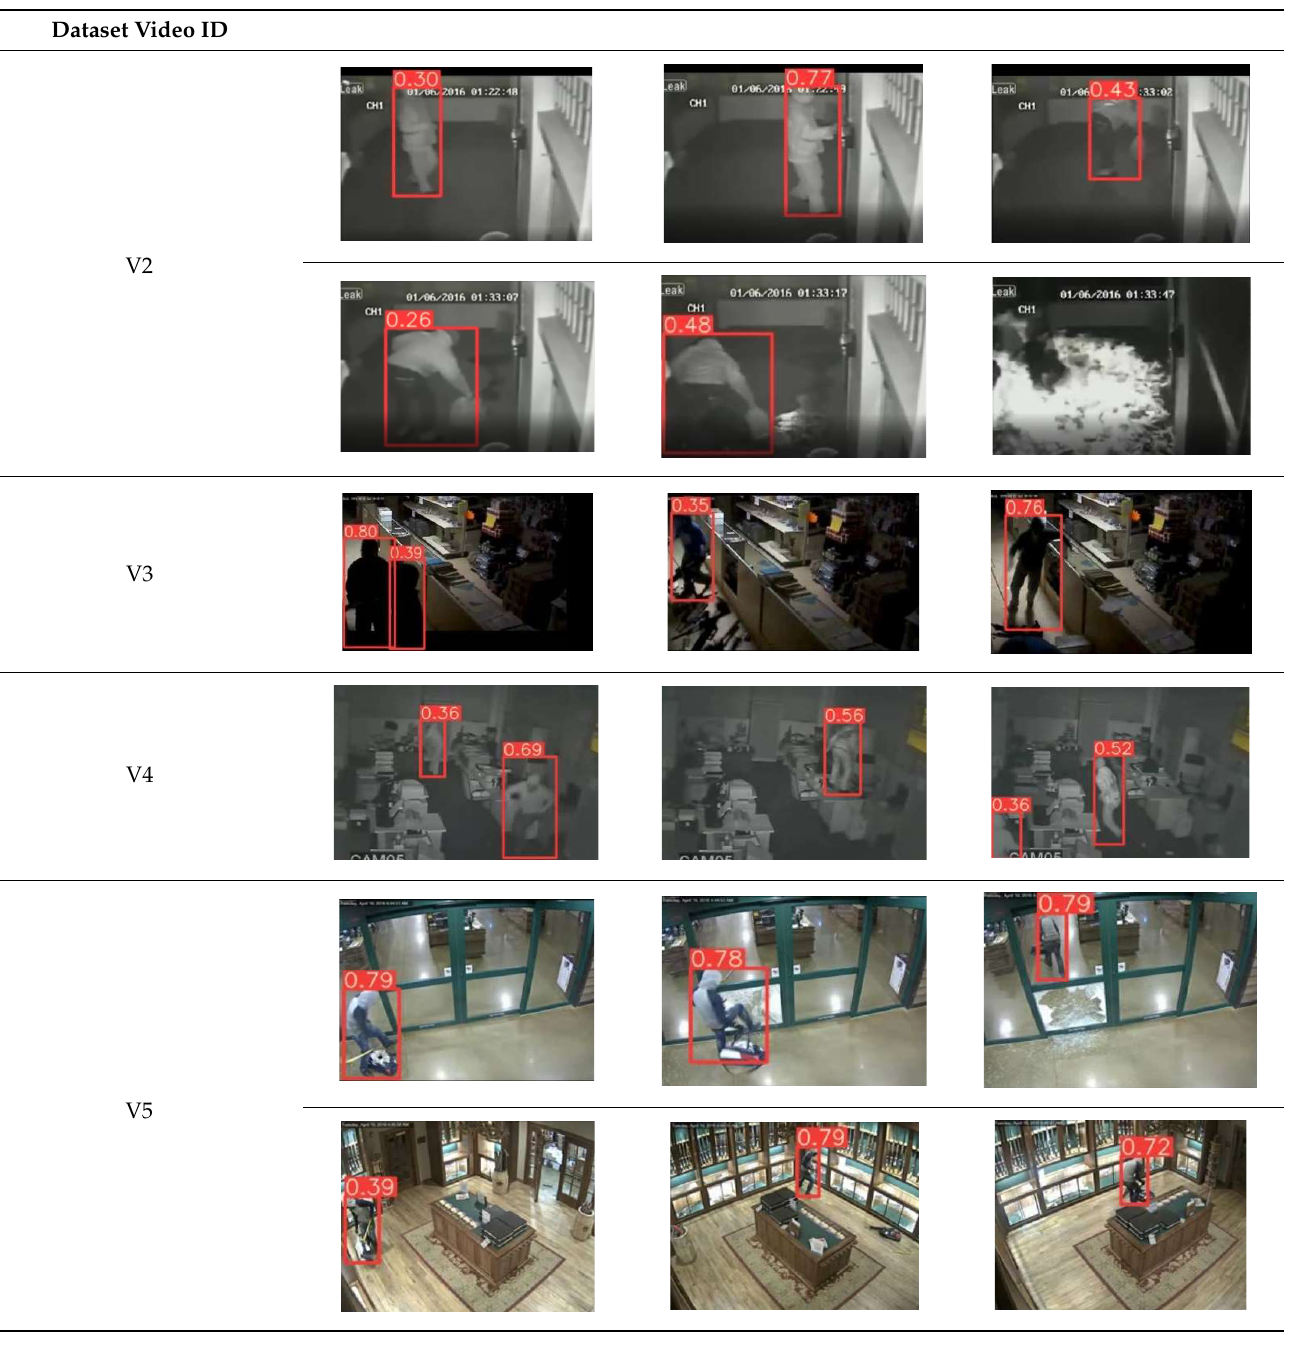
Table 5. Quantitative person detection results per selected video via the pre-trained YOLOv5s.